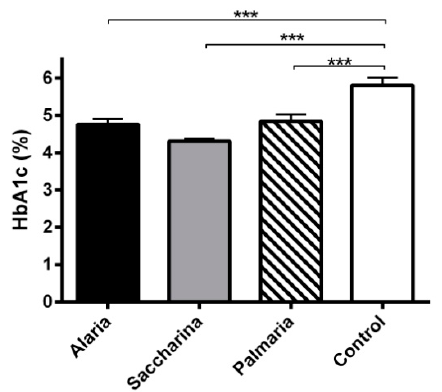
Figure 2. Glycated hemoglobin (HbA1c) from the KK-Ay mice at the end of the 11-week intervention with diets supplemented with Alariaesculenta , Saccharinalatissima , or Palmariapalmata compared to chow (control). The control group had significantly higher glycated hemoglobin levels compared to all of the seaweed groups *** ( p < 0.001). Values are means ± SEM.